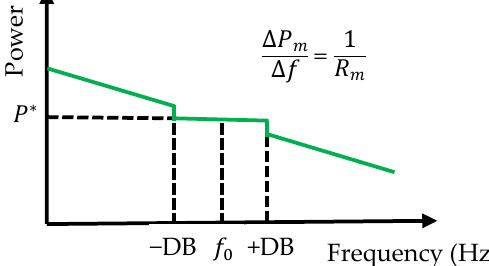
Figure 1. Typical power–frequency droop characteristic.